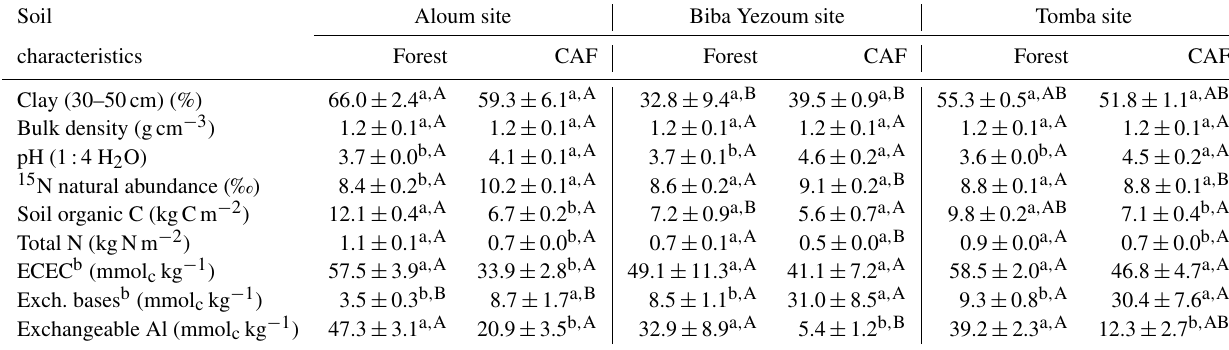
Table 1. Mean ( ± SE, n = 4) soil biochemical characteristics in the top 50cm a depth in forest and cacao agroforestry (CAF) within each site in the Congo Basin, Cameroon. Means followed by different lowercase letters indicate significant differences between land-use types within each site, and different capital letters indicate significant differences among the three sites within a land-use type (ANOVA with Tukey’s honest significance difference (HSD) test or Kruskal–Wallis ANOVA with a multiple-comparison extension test at P ≤ 0 . 05).